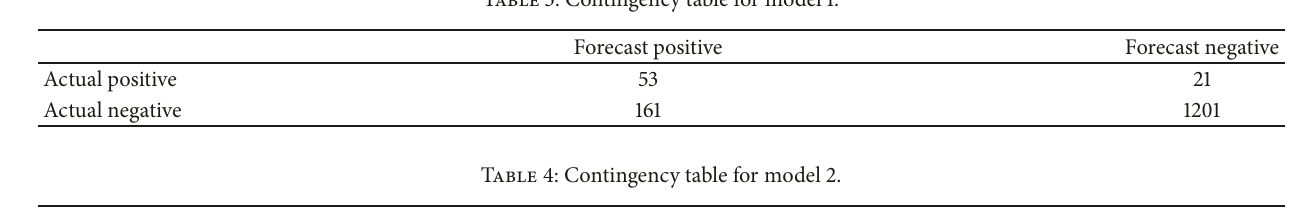
Table 3: Contingency table for model 1.